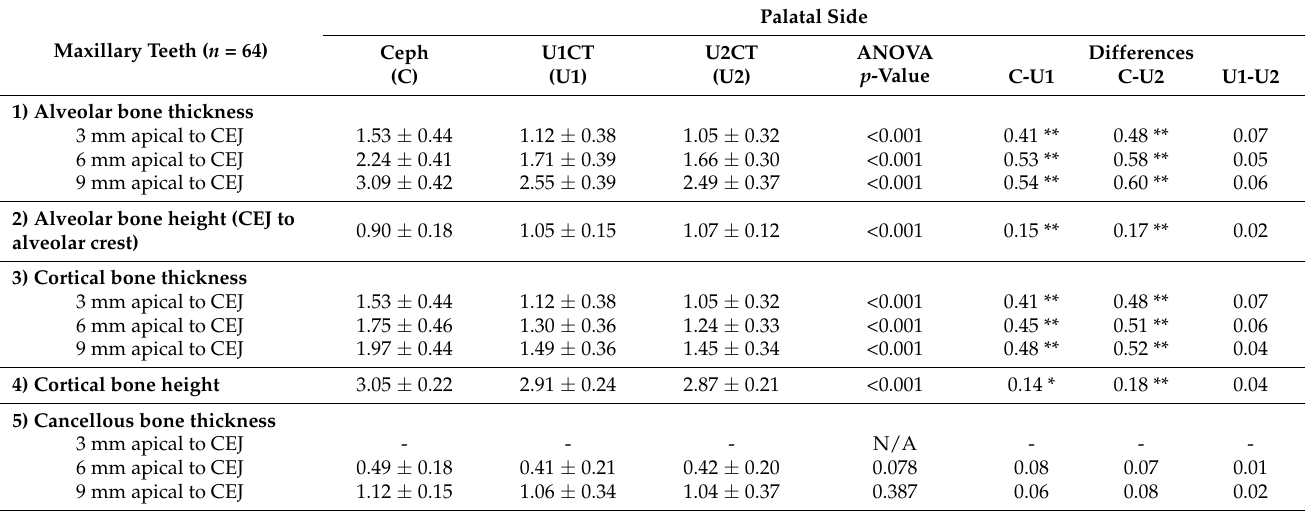
Table 2. Comparisons of palatal alveolar bone between Ceph, U1CT, and U2CT.